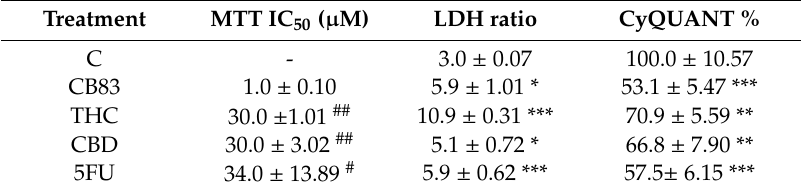
Table 1. Results from the MTT, lactate dehydrogenase (LDH), and CyQUANT